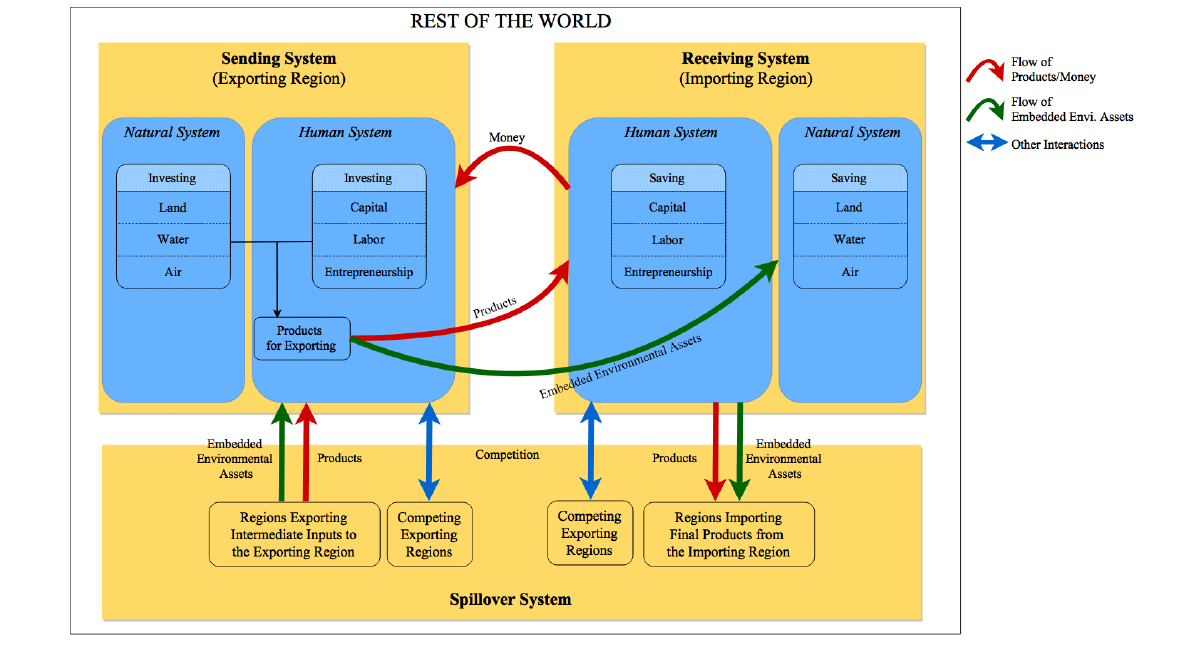
Fig. 1 . Trade in the telecoupling framework. Our emphasis is on flows, which we quantify for the global trade of metal products and their embedded environmental assets (green and red